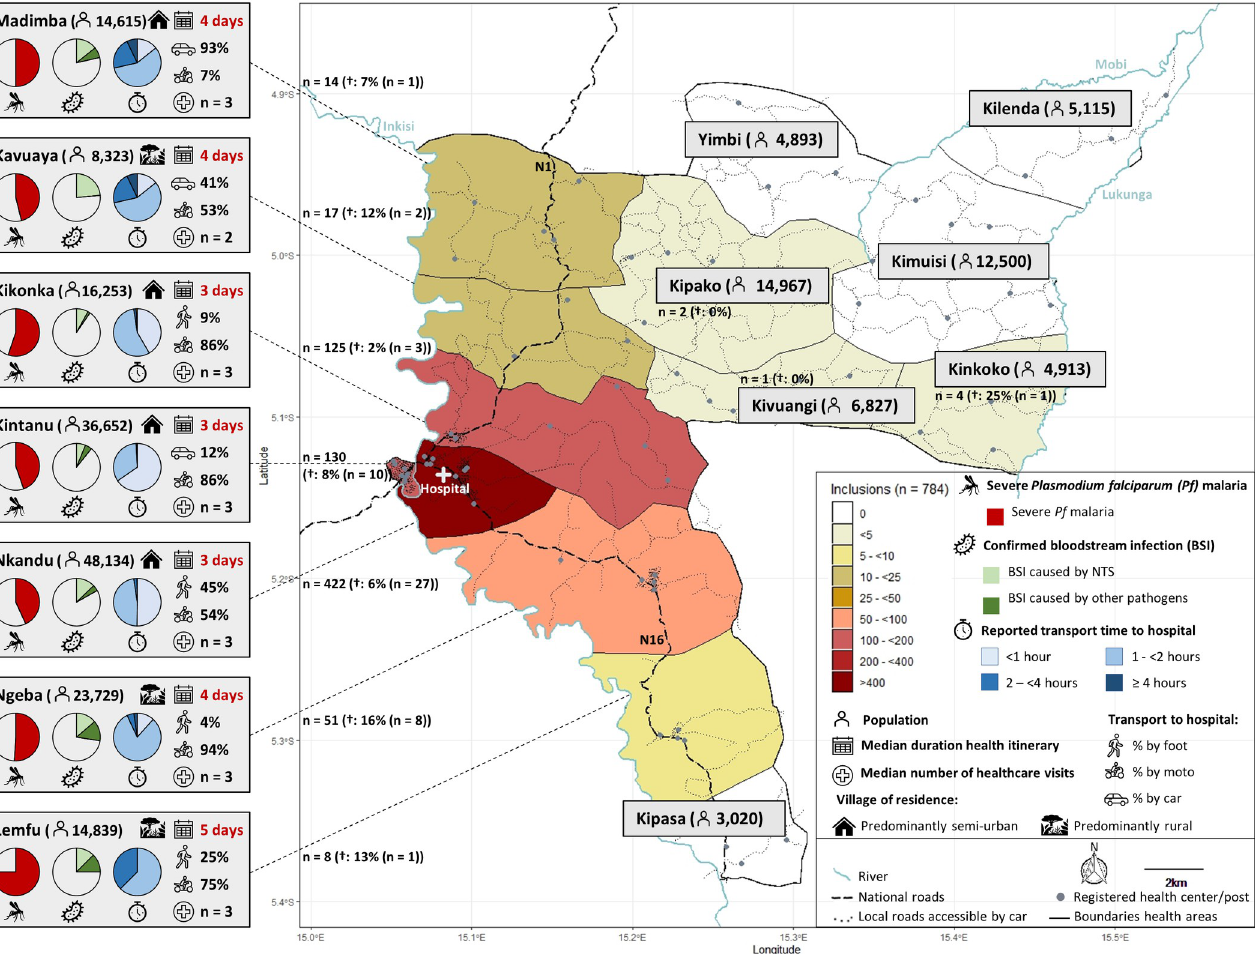
Fig 1. Geographical overview displaying (i) the population and healthcare services, (ii) the number of enrolled children and proportion of in-hospital deaths (†), (iii) the health itinerary (duration (time since fever onset), transport to hospital, number of visits) and (iv) the diagnostic category of enrolled children for each health area from Kisantu health district. The map was created with R-packages ‘sf‘ & ‘ggsn’ and map base layer data are available open access from http://www. rgc.cd/. [15]Abbreviations: BSI: bloodstream infection; NTS: non-typhoidal Salmonella; Pf : Plasmodium falciparum .